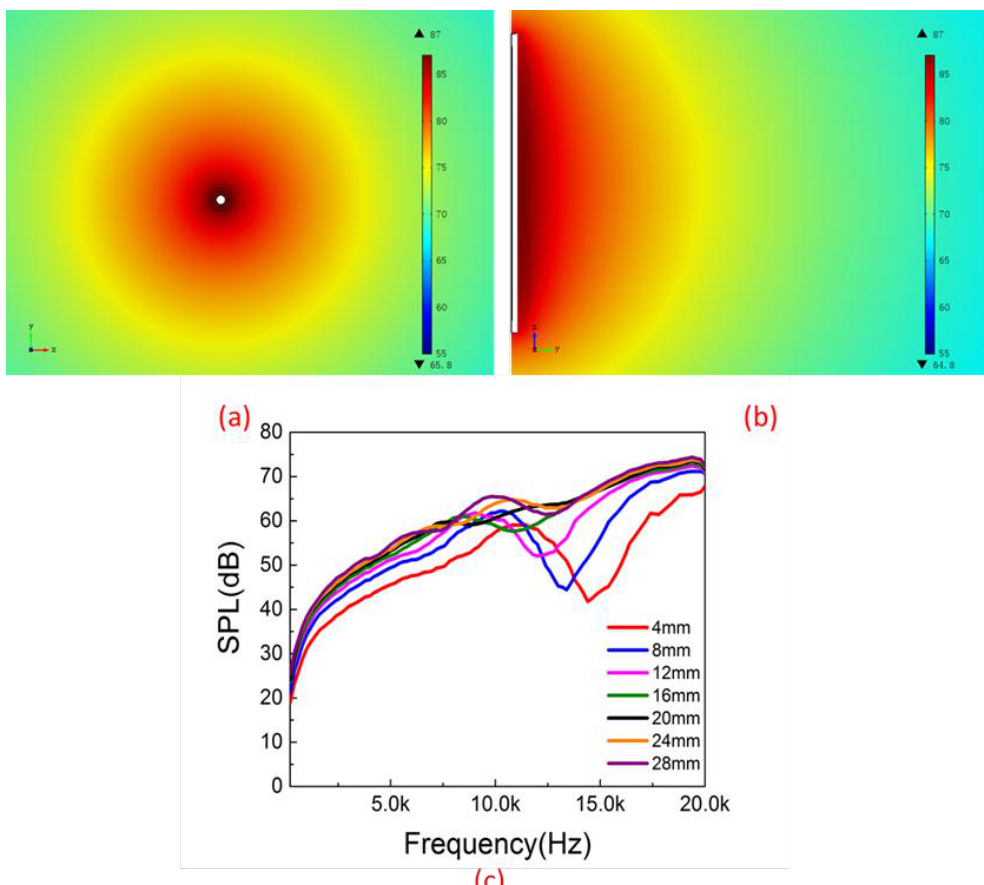
Figure 6. Simulation of the sound field for the device. ( a ) The sound field of horizontal plane of the device working at 20 kHz, showing great uniformity at 360 degrees. ( b ) The sound field of the vertical plane of the device working at 20 kHz. ( c ) The theoretical sound pressure level (SPL) vs . frequencies ranging from 100 Hz to 20 kHz.